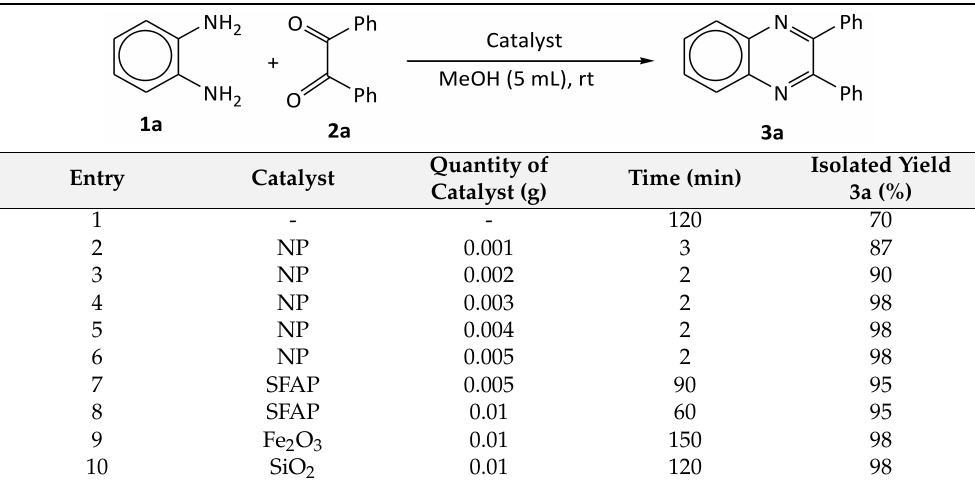
Table 4. Effect of various amounts of catalyst on the synthesis of 3a .